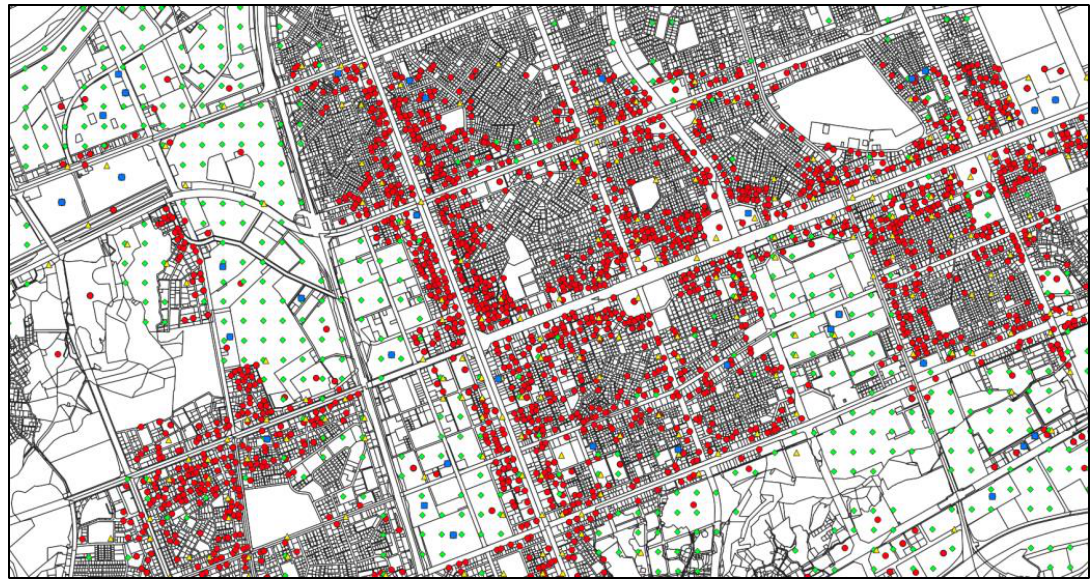
Figure 5. An area in Seoul marked with entities of interest (red circles: restaurant businesses; green diamonds: residential complexes; yellow triangles: convenience stores; blue squares: large shopping malls).